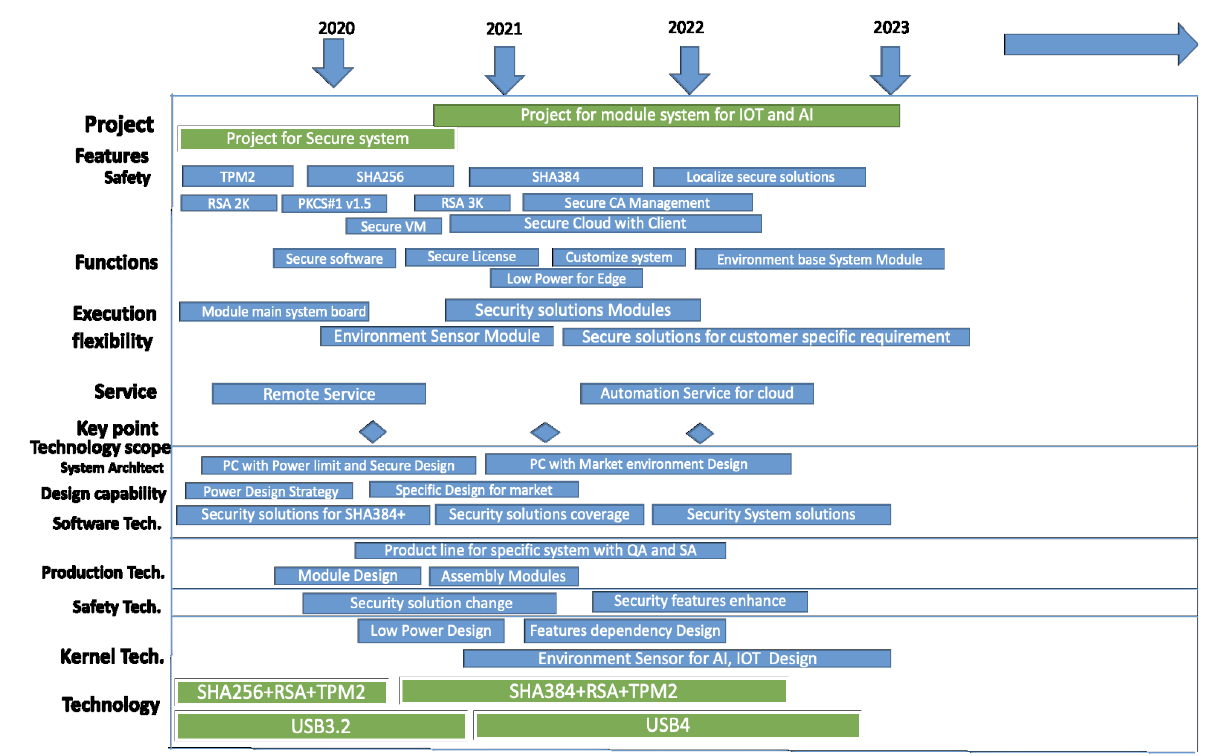
Figure 18. Technology strategy roadmap for AI and